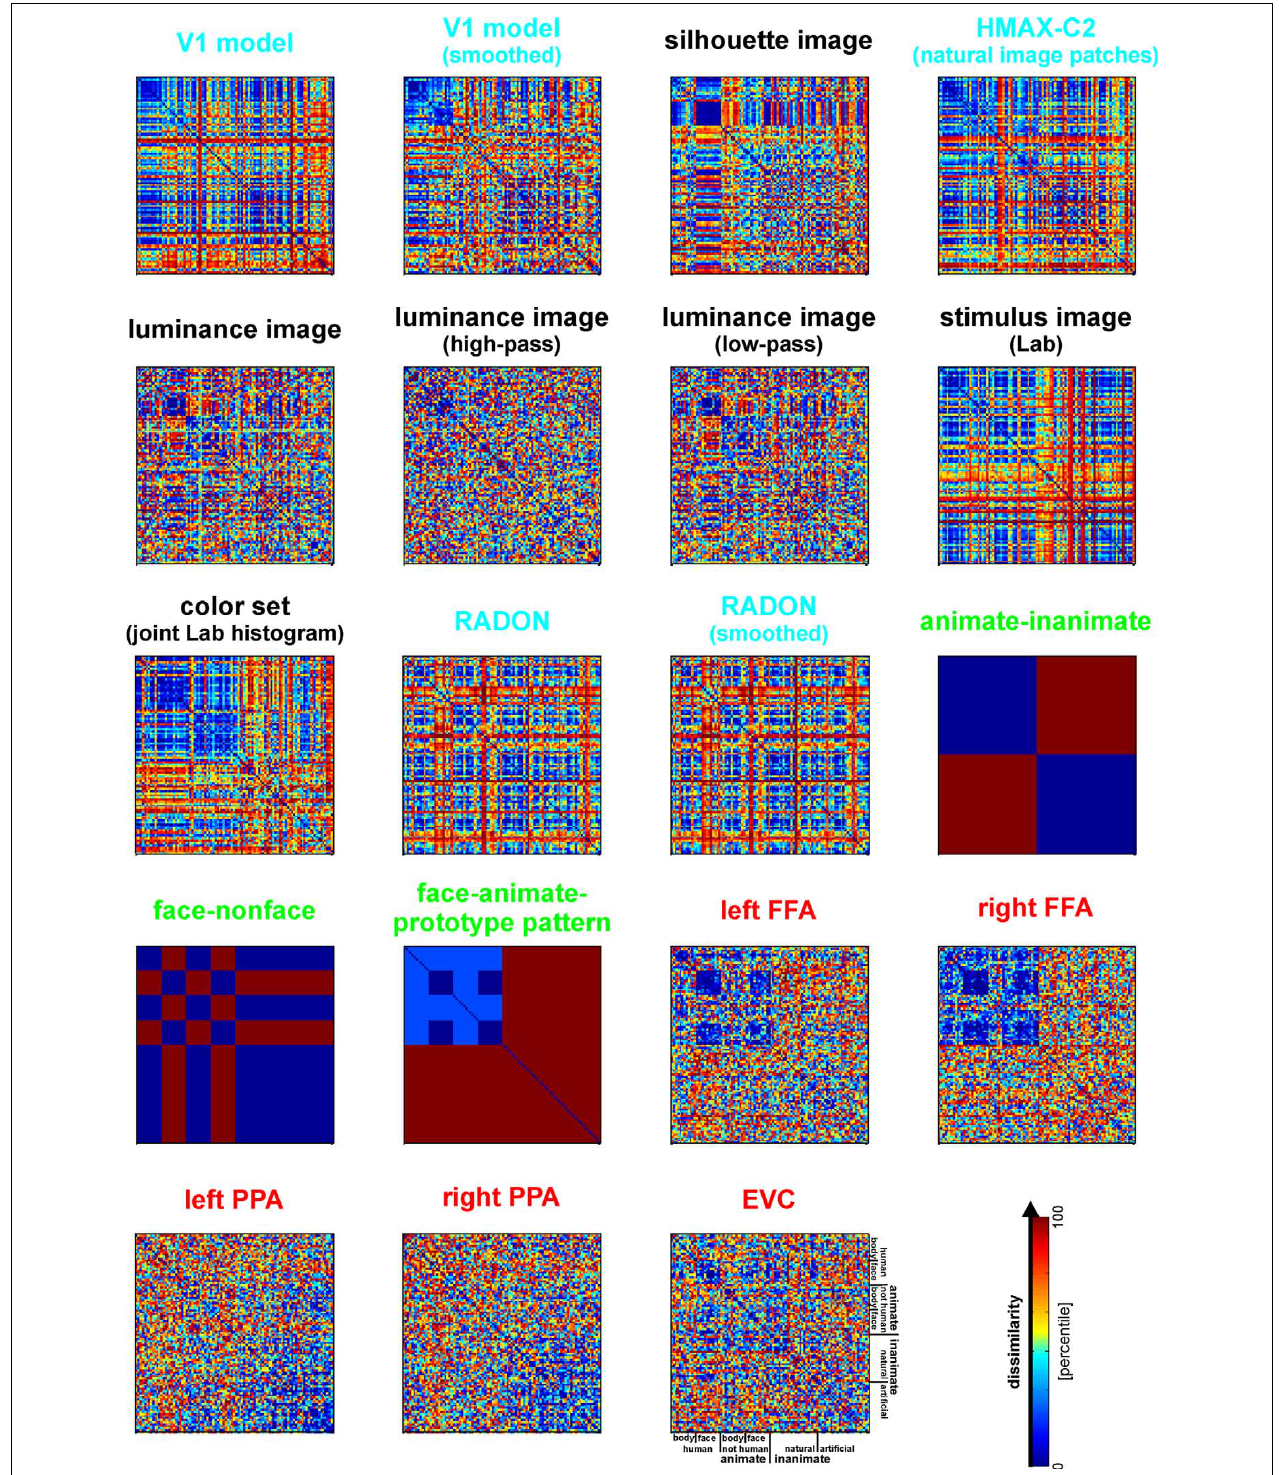
FIGURE 6 | Representational dissimilarity matrices for models and brain regions . Dissimilarity matrices for model representations and regional brain representations (as introduced in Figure 2 ). The dissimilarity measure is 1 − correlation (Pearson correlation across space). Note that each model yields a unique representational similarity structure that can be compared to that of